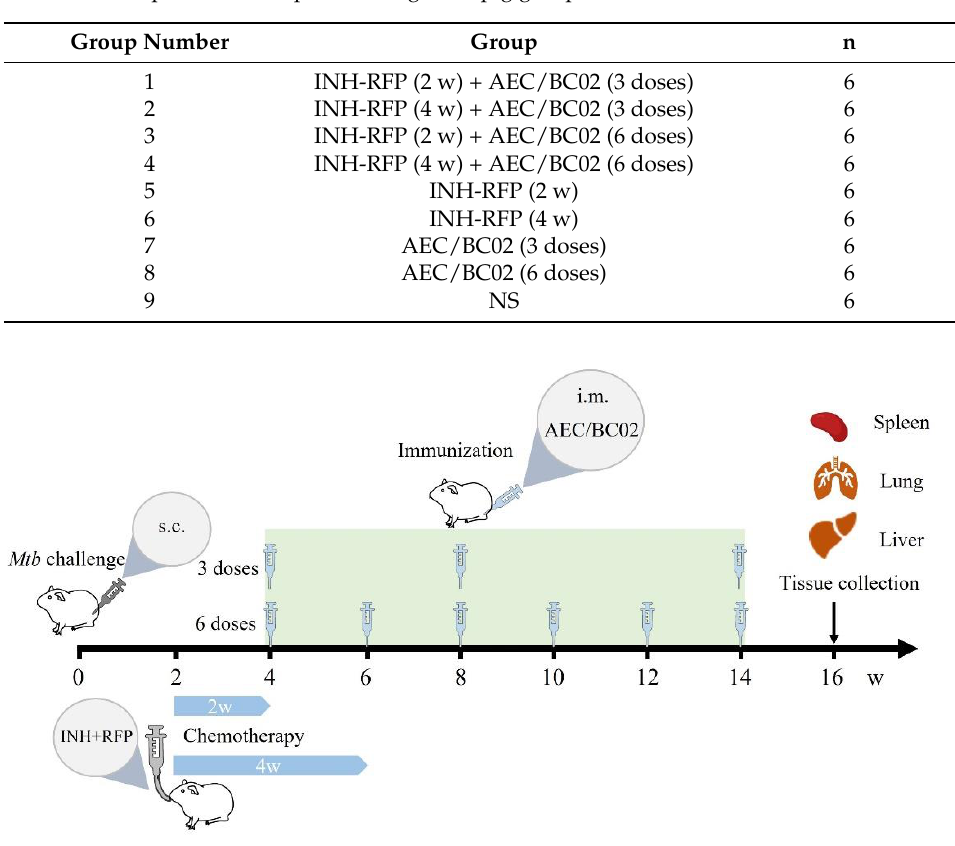
Figure 1. The optimal immunotherapy schedule for evaluation of a potential vaccine candidate in a M.tb latently infected guinea pig model. All guinea pigs were subcutaneously infected with M.tb into the groin for 2 weeks, followed by intragastric administration of INH + RFP for 2 or 4 weeks. Guinea pigs were injected intramuscularly with three or six doses of AEC/BC02 vaccine at 4 weeks after infection, and the animals were dissected at 2 weeks after immunization. The negative control group was injected with the same dose of saline during chemotherapy and immunization.